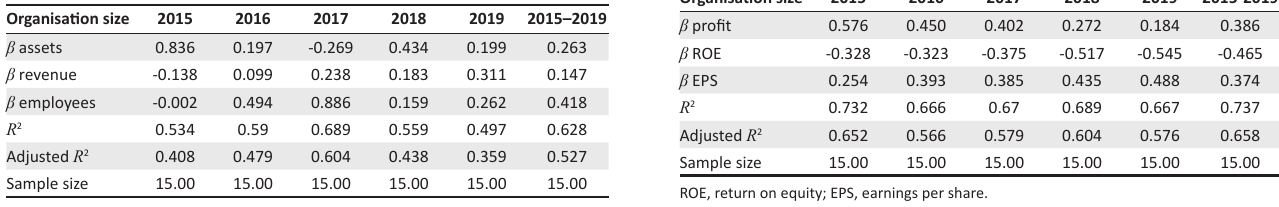
TABLE 3: Multiple regression – Organisation size on chief executive officers’ total remuneration. Organisation size